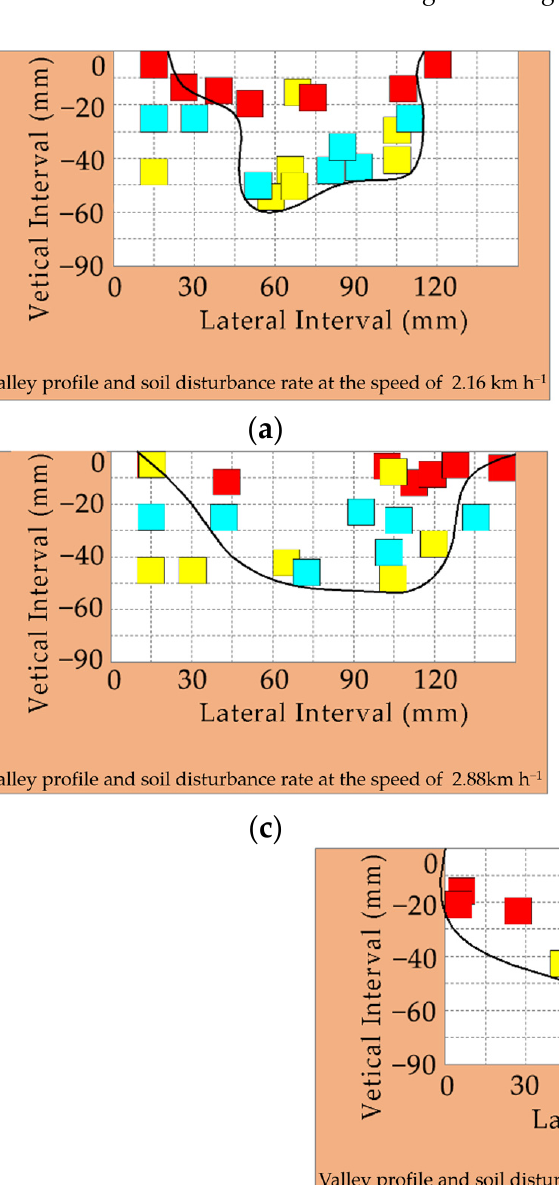
Figure 8. Effect of the operating speed on the gully profile. As shown in Figure 9, the furrowing operation was carried out at speeds of 2.16 km h − 1 to 3.60 km h , and the gully profile curve was plotted using the displacement changes in